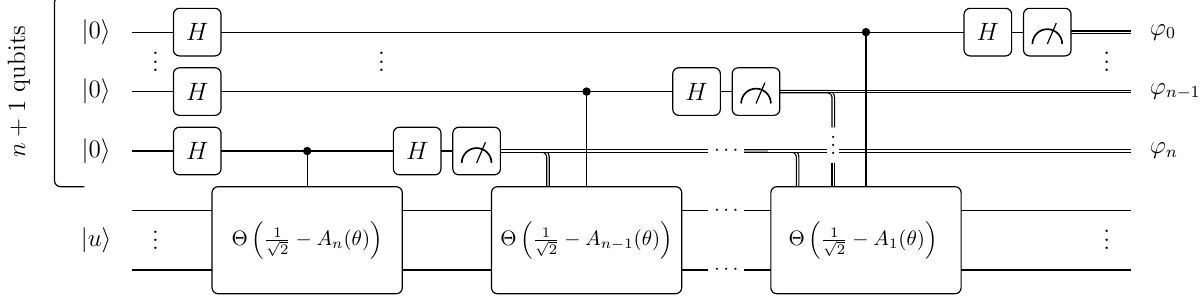
FIG. 11. An abstract overview of the circuit performing phase estimation through the QSVT (Algorithm 3). The double lines indicate that measurement results are fed forward (via the parameter θ ) to all future controlled QSVT operations, where this adaptive process is unpacked in Fig. 12. In essence, the circuit systematically computes the least significant bit of an unknown quantum phase, adaptively bit shifts this phase, and repeats. Note the similarity of this operation to the inverse quantum Fourier transform, a connection on which we elaborate in Sec. V